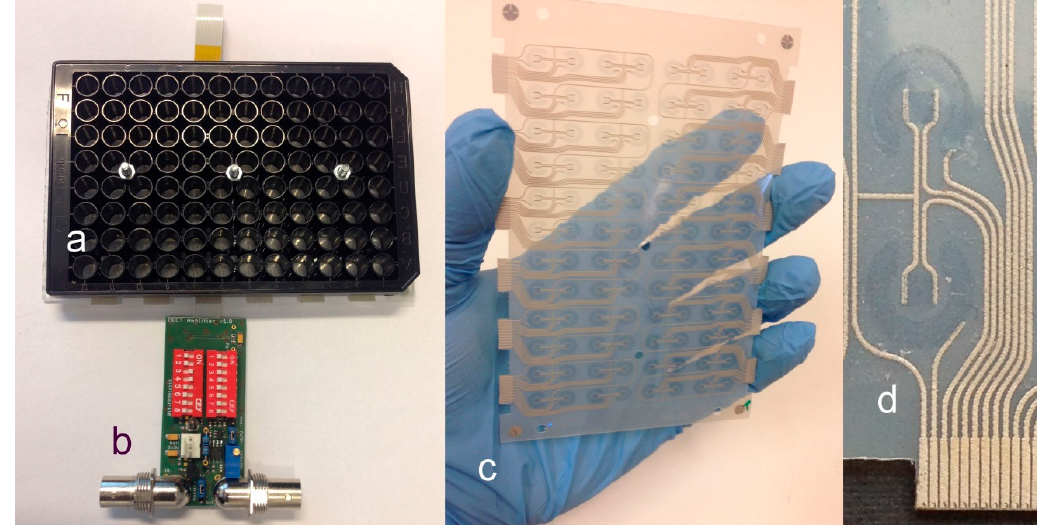
Figure 1. Encapsulated organic electrochemical transistor (OECT) 96 well microplate for electrogenic cell cultivation and investigation ( a ) with a power source-signal amplifier and current/voltage converter ( b ), foil with functional printed patterns of all OECTs in a 12 × 8 array ( c ), and a detail of a couple of OECTs with a poly(3,4-ethylenedioxythio-phene) :poly(styrene sulfonic acid)—PEDOT:PSS printed channel and gate electrode ( d ).